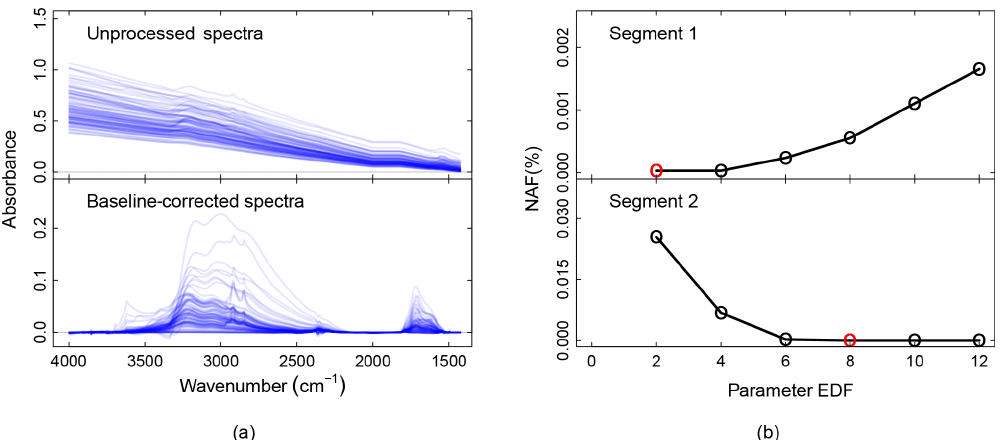
Figure 4. Baseline correction package outputs. (a) From top to down, the panels show the unprocessed and the baseline-corrected spectra of ambient samples collected on PTFE filters. A detailed description of these ambient samples can be found in the companion paper (Reggente et al., 2019). Absorbance scale in arbitrary units (a.u.). (b) The EDF selection criteria for segment one and two. The red circles represent the EDF values that minimize the median of the selection criteria NAF. In the current implementation of the chemometric package, segment one and two refer to spectra in the regions 4000–1820 and 2000–1500cm − 1 , respectively (Kuzmiakova et al.,